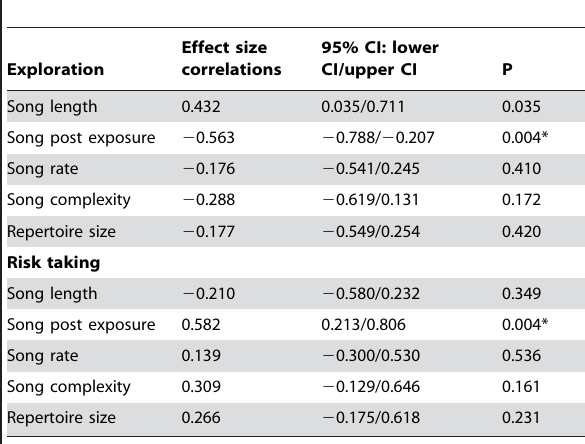
Table 1. Relationships between features of song and the degree of exploration of an environment altered with a novel object and flight distance reflecting personality in male collared